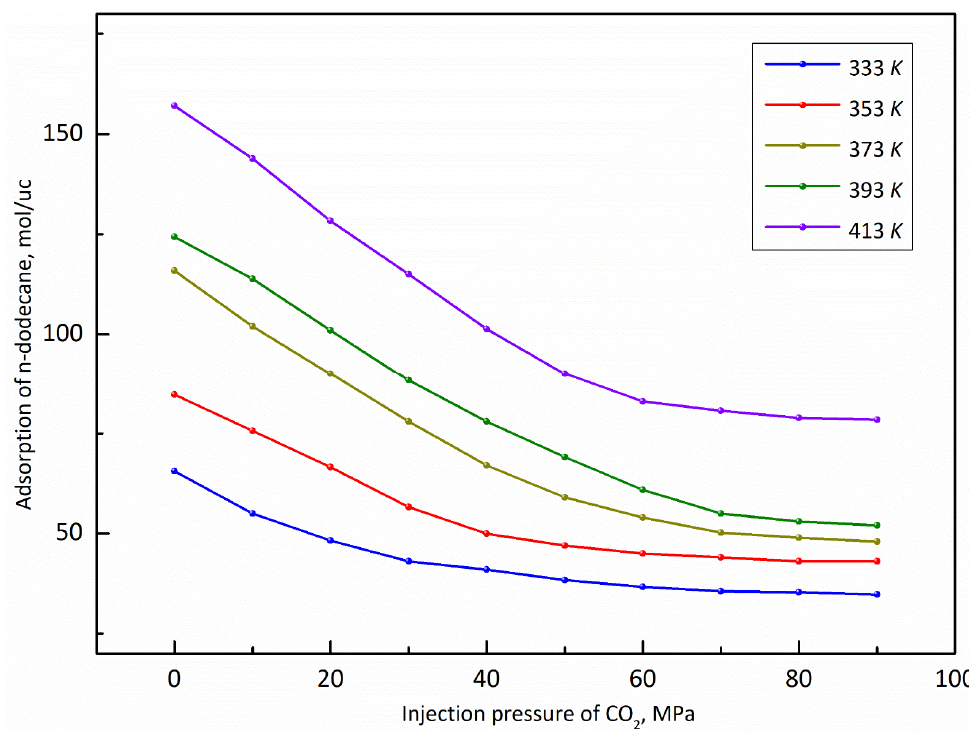
Figure 9. The molar quantity of n-dodecane absorbed in the pores under different temperature at different injection pressure of CO 2. Further, the effect of the temperature on the displacement of n-dodecane is displayed in Figure 11. As illustrated in Figure 11, we can observe that the displacement capacity of n-dodecane by CO 2 is stronger at higher temperature. And, when the temperature of shale oil reservoir is lower than 373 K , the displacement capacity of n-dodecane increases dra- matically. For instance, when the temperature increases from T = 333 K to T = 373 K, the displacement capacity of n-dodecane increases from 28.97 mol/uc to 60.42 mol/uc with an increasing ratio of 108.56%, while the increasing ratio is only 16.57 % when the tempera- ture increases from T = 373 K to T = 413 K. Based on that phenomenon, we can conclude that there is an optimal temperature that the maximum displacement capacity of shale oil by CO 2 can be obtained from the perspective of economic production.